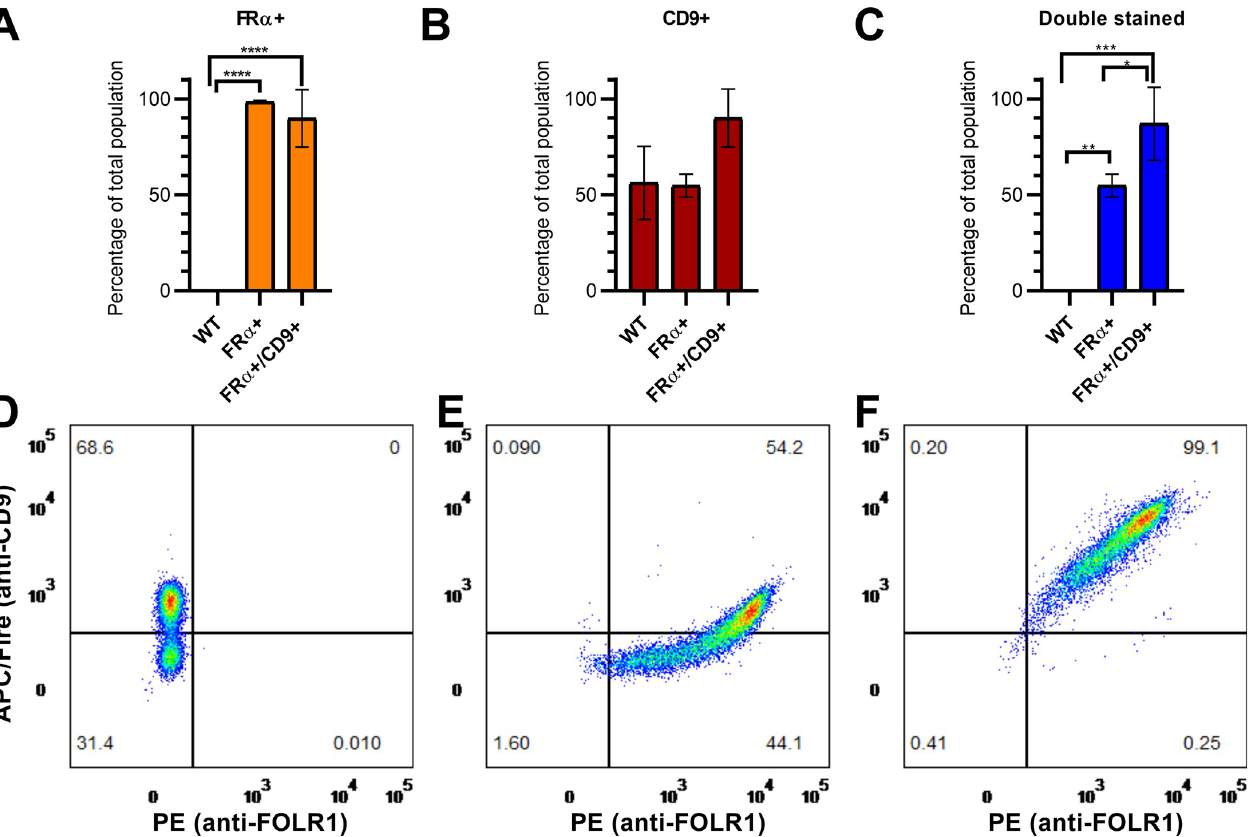
Fig 5. EVs protein markers after isolation with anti-CD63 beads. (A) Percentage of FR α + particles for each cell line, measured by flow cytometry. (B) Percentage of CD9+ particles, measured by flow cytometry. (C) Percentage of particles positive for both markers, measured by flow cytometry. (D) Example of flow cytometry of a EVs sample from WT cells after anti-CD63-beads purification. (E) Example of flow cytometry of a EVs sample from FR α + cells. (F) Example of flow cytometry of a EVs sample from FR α +/CD9+ cells. Data are represented as mean ± s.d. (n = 3 for each line). ��� = p � 0.001.